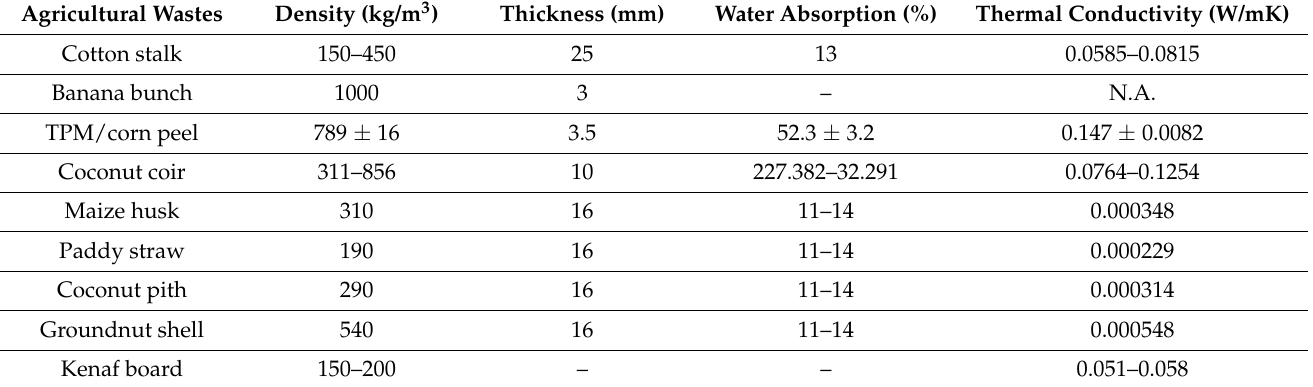
Table 7. Physical properties of insulation boards from agricultural wastes [89].